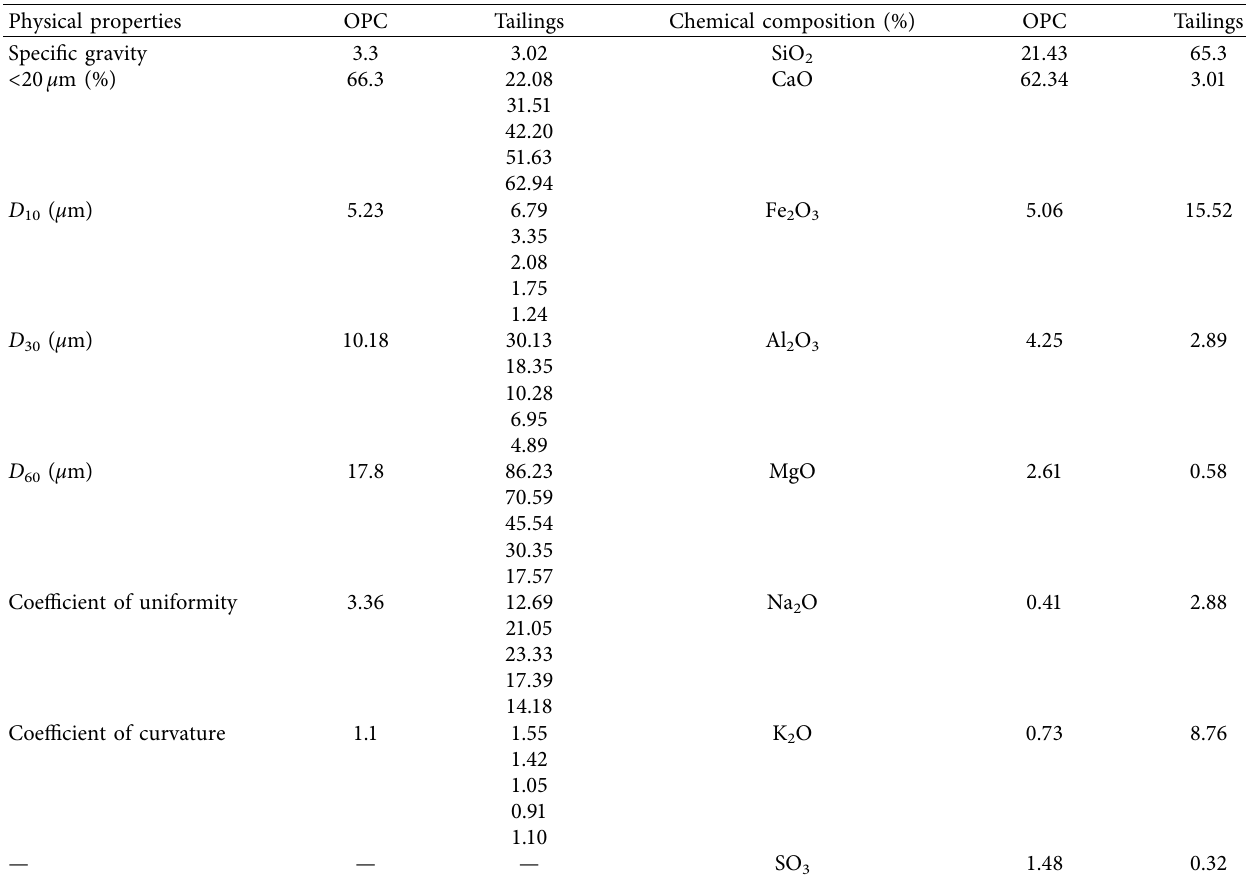
Table 1: Main chemical and physical properties of OPC and tailings.